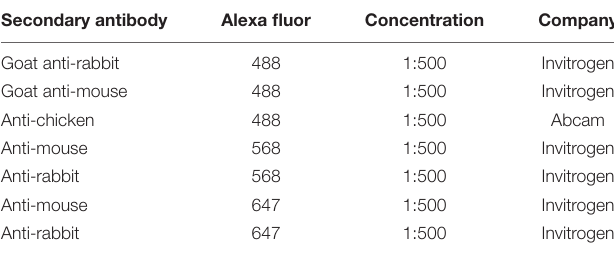
TABLE 2 | Secondary antibodies for immunohistochemistry